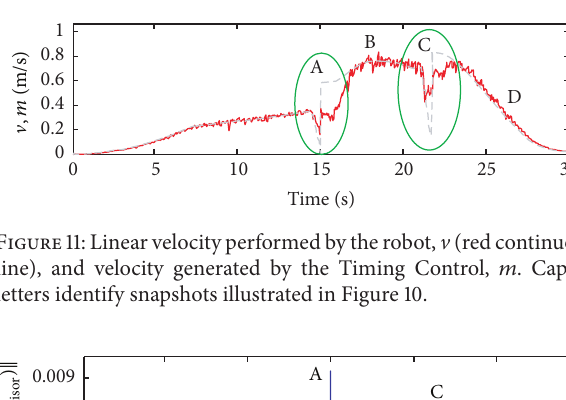
Figure 12: Evolution of ‖𝐷(𝑓 of experiment 1. Capital letters identify snapshots illustrated in Figure